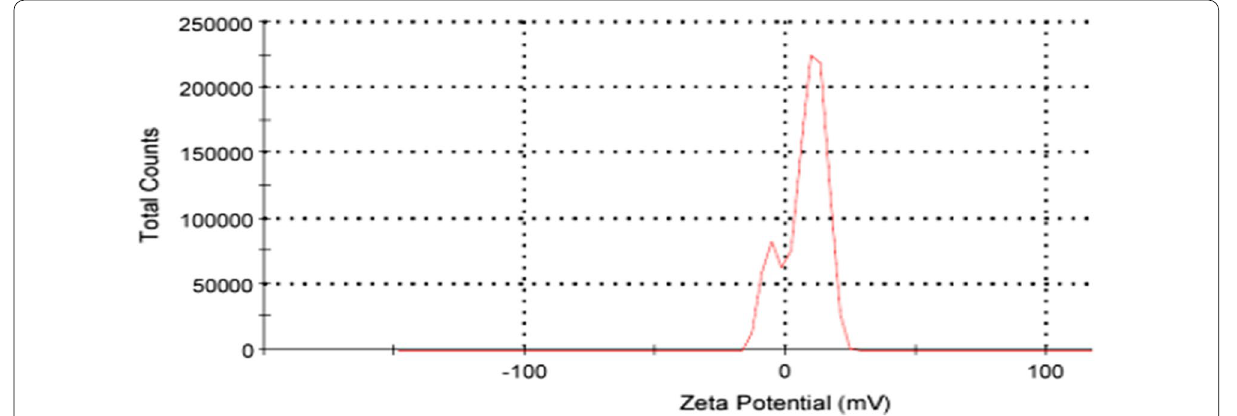
Fig. 2 Zeta potential of